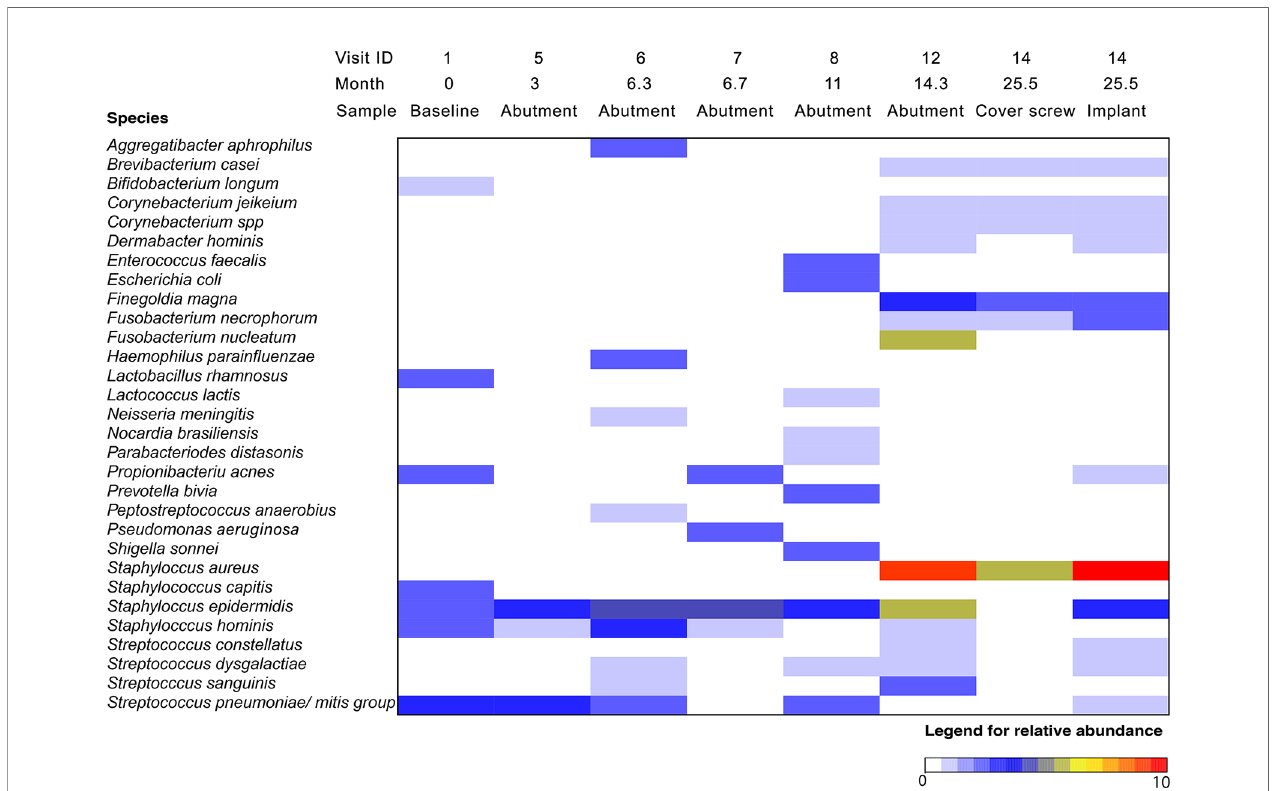
FIGURE 3 | Relative abundance of bacteria on BAHS over time using the IS-pro technique. The color indicates the relative abundance of speci fi c bacterial species at each time point, with red indicating the highest abundance. Location indicates the area where a cotton swab was taken for microbiological analysis: at the baseline, a swab of the intended implantation site was obtained; at different visits, a swab of the skin penetrating abutment and 1 cm of peri-abutment skin was obtained; and at implant retrieval, two additional swabs were obtained from the implant and cover